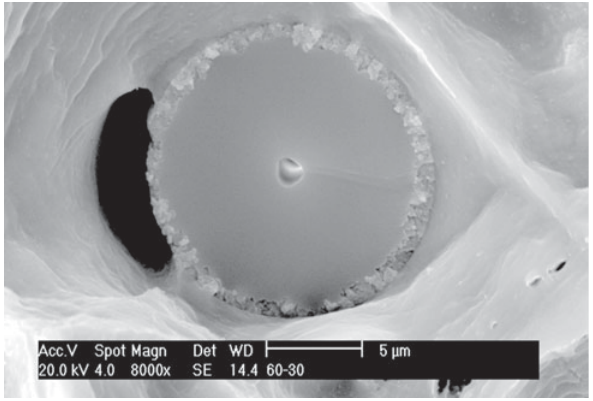
Figure 5. SEM microscopy on fractured composite showing a fiber partially reacted and strong inserted into the dimple. No pullout occurred.